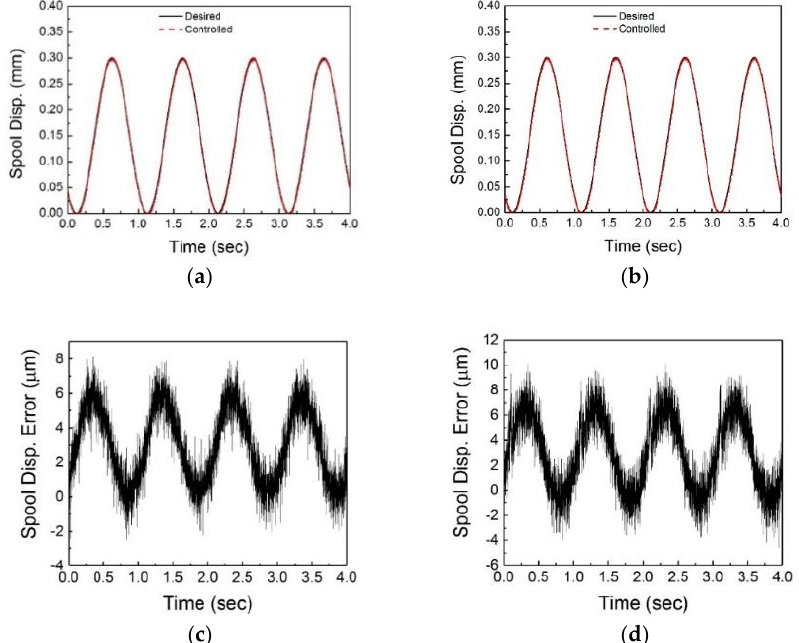
Figure 11. Tracking control results via fuzzy PID controller at 1 Hz, ( a ) Tracking control result at 30 ◦ C, ( b ) Tracking control result at 150 ◦ C, ( c ) Tracking error at 30 ◦ C, Tracking error at 150 ◦ C .